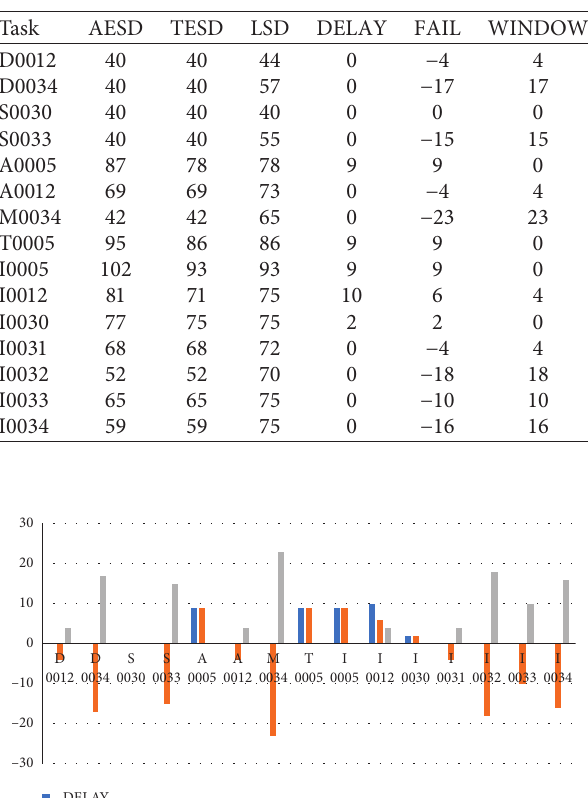
Table 5: Data summary.